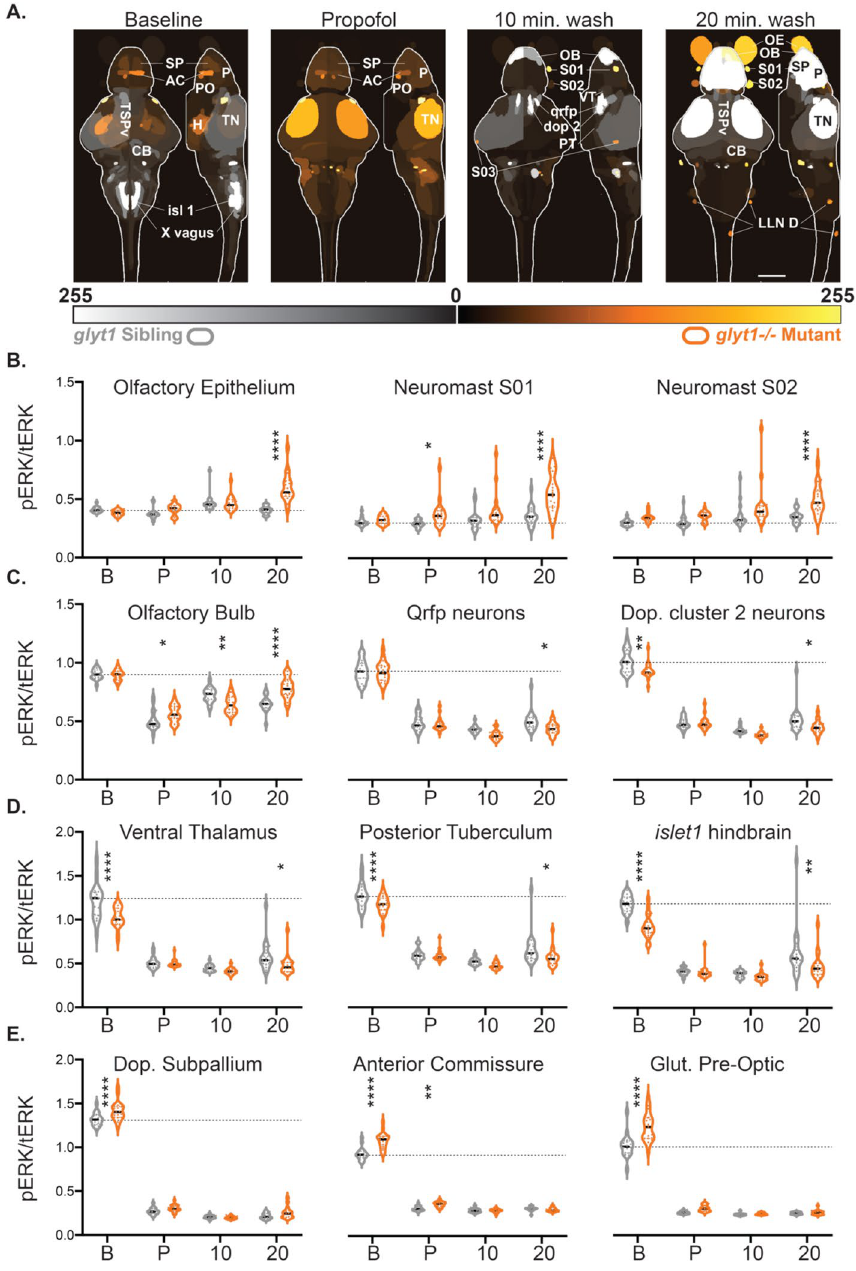
Figure 7. glyt1−/− mutants’ sensory ganglia are more active while arousal and motor circuits are less active than their siblings during recovery from propofol. ( A ) Brain regions of interest (ROIs) that are significantly different between glyt1−/− mutants and their siblings are shown on reference brains for Baseline , Propofol, 10 min. wash and 20 min. wash conditions with sample size indicated at the base of each image. ROIs are labeled with the corresponding anatomical brain regions; an abbreviation key can be found at the end of the figure legend. ( B – D ) Violin plots of pERK/tERK ratios for twelve different brain regions are shown with a dashed line indicating median pERK/tERK levels in baseline glyt1 siblings. For each brain region, we conducted a 2-way ANOVA for genotype and condition followed by Sidak’s multiple comparisons of genotype across conditions. Asterisks indicate p -value: * p < 0.05, ** p < 0.001, *** p < 0.001, **** p < 0.0001. ( A ) Three sensory ganglia are shown that are elevated in glyt1 mutants during recovery. ( B ) Olfactory bulb and arousal pathways are shown. ( C ) Premotor and motor regions elevated in baseline glyt1 siblings are shown. ( D ) Hypnotic regions elevated in baseline glyt1−/− mutants are shown. Anatomical abbreviations: OE olfactory epithelium, subpallium SP , pallium P , Preoptic nucleus PO , Hypothalamic nucleus enriched in Qrfp-expressing neuronal cell bodies Qrfp , Ventral Thalamus VT , Dopaminergic Cluster 2 in the posterior tuberculum Dop 2 , Tectum Stratum Periventriculare TSPv , Tectum Neuropil TN , Cerebellum CB , vagal motor nucleus X , posterior Lateral Line Neuromasts along the body LLN D . Scale bar = 100